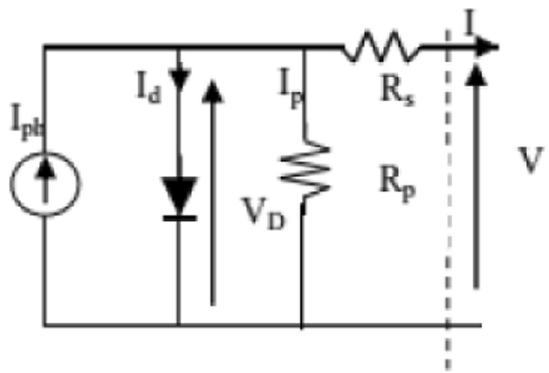
Fig. 2 General PV Cell Model